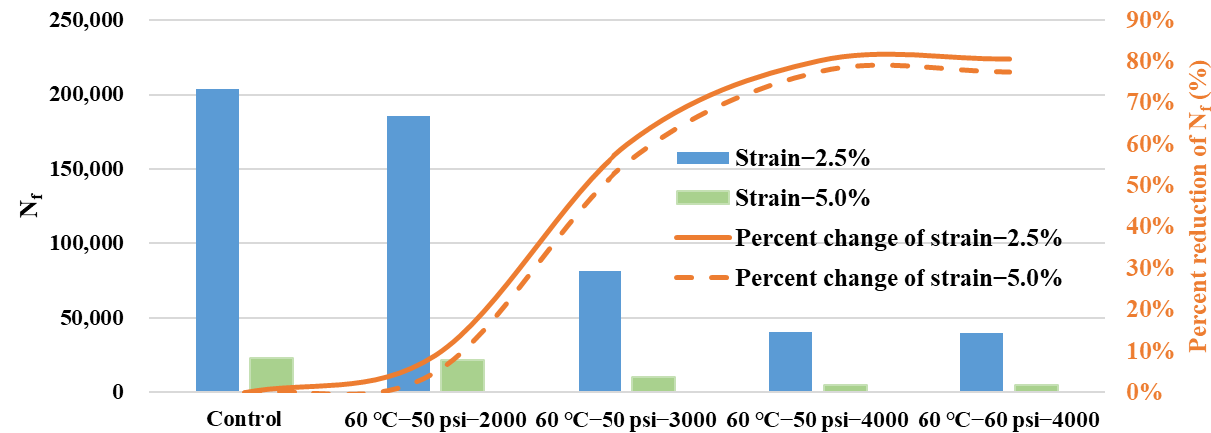
Figure 10. Fatigue life of asphalt binder in LAS tests.